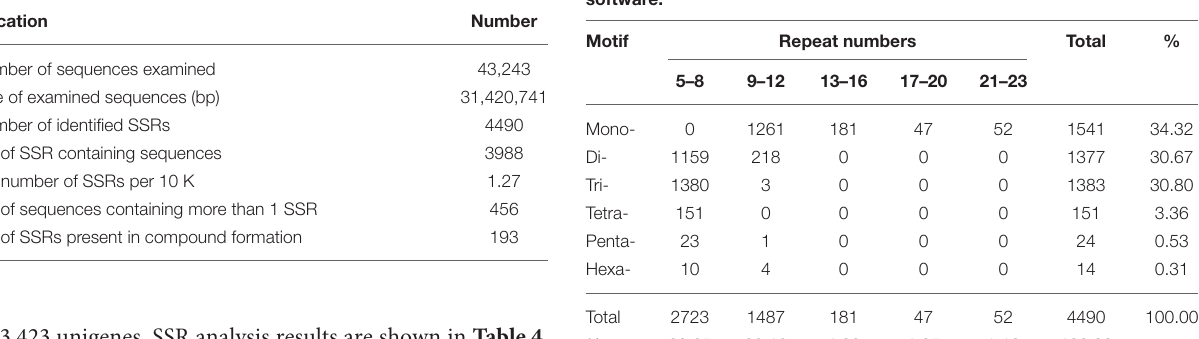
TABLE 4 | Statistics of SSR search results in D. asperoides . TABLE 5 | Distribution of identified SSRs from D. asperoides using MISA